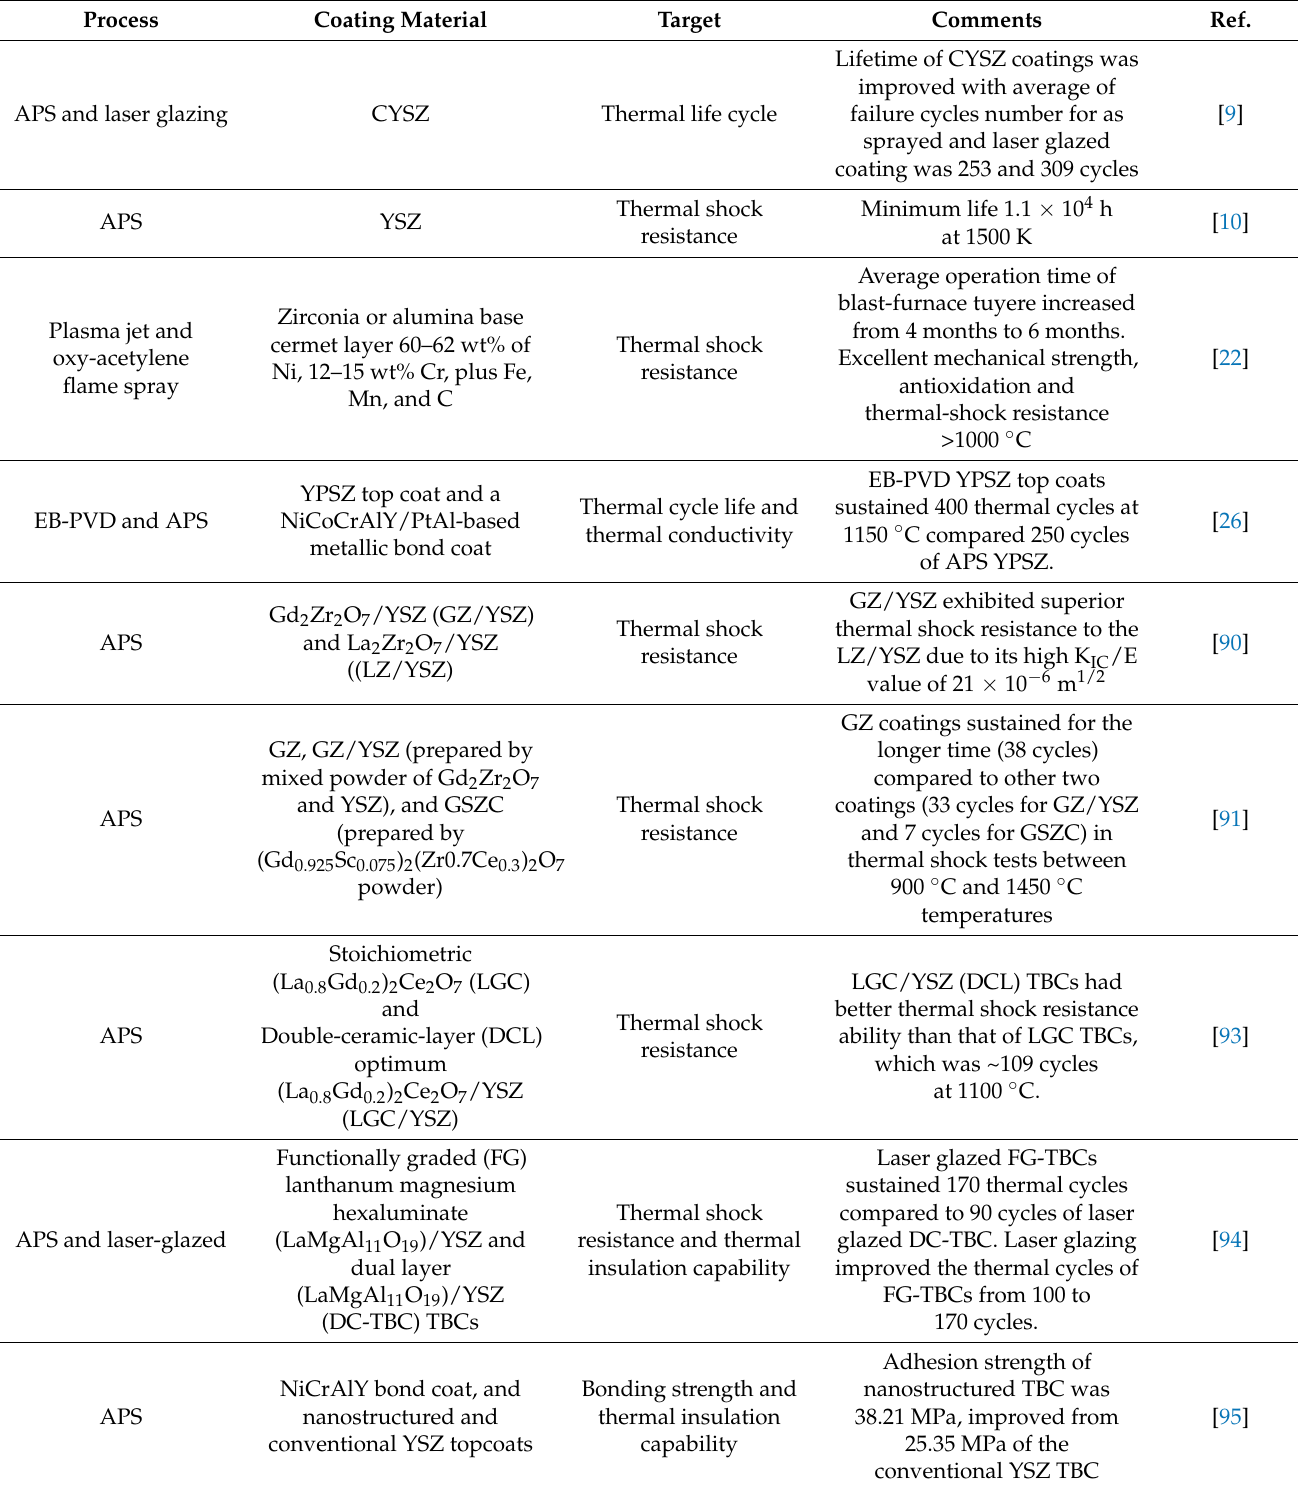
Table 3. Development of coating material and thermal spray process to produce thermal barrier coatings for the iron and steel making